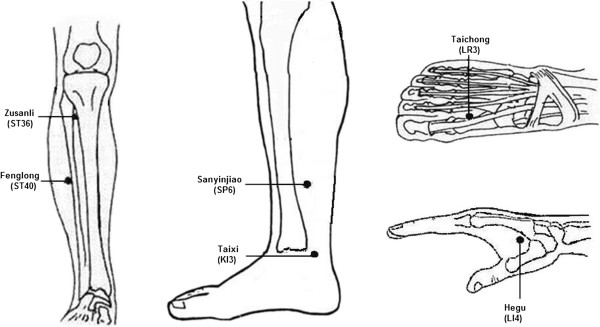
Acupoint locations.